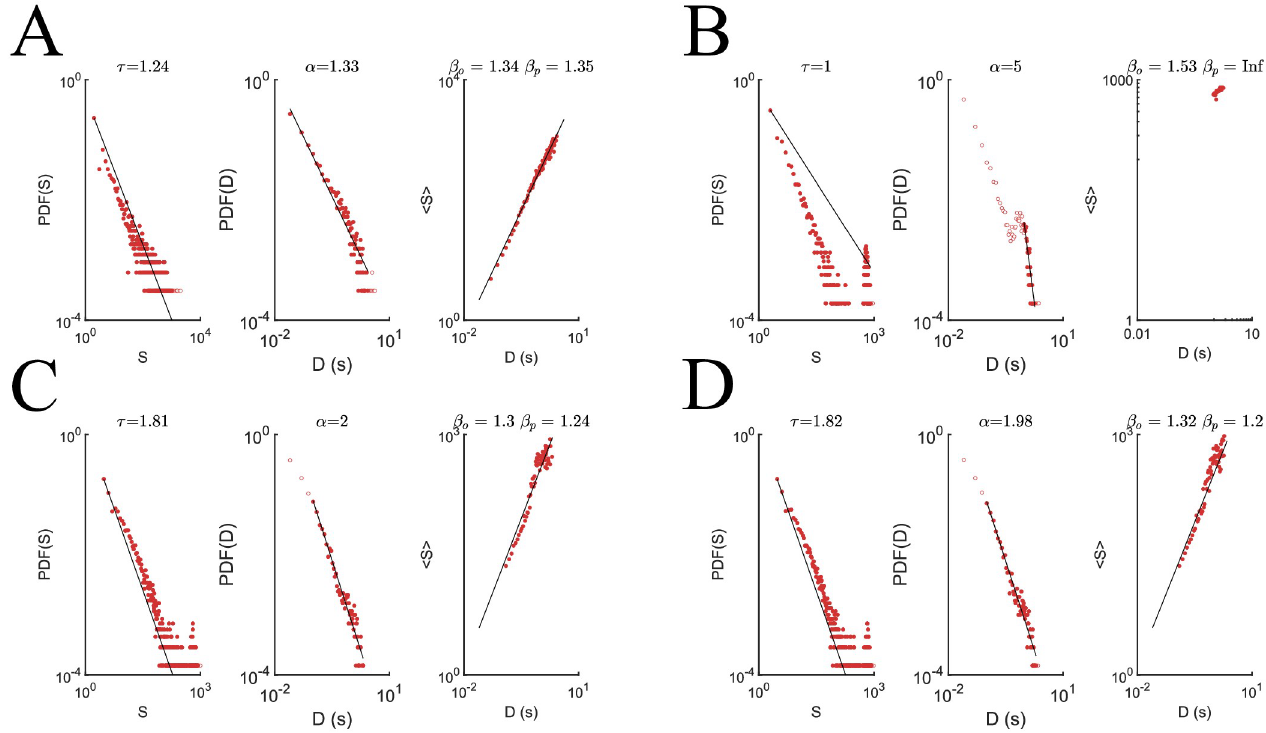
Fig 8. Improvement in ISI goodness of fit and basic spike statistics dependent on initial network configuration. ( A ) ℓ 2 distance measures between ISI histograms and basic spike statistics for uniform initial reference and naive networks (Methods). The plots are organized left to right for reference, naive, optimized, and finally control conditions. The ISI goodness of fit improves during optimization indicating similarity in the reference and optimized inter-spike interval distributions. For the uniform initial distributions, the control ISI ℓ 2 distances are lower on average than those of the optimized networks, but for all other initializations, the ISI ℓ 2 distance is lowest for the optimized condition. Means and variances of spike number are computed by recording the number of spikes in each neuron’s spike train and taking averages and variances over neurons. While the mean spike number is roughly unchanged through optimization (from naive to optimized), the variance in spike number diverges from the reference value. ( B ) For the gaussian initial network configuration, ISI ℓ 2 for the optimized network is greater on average than that of the control, but in both cases improves during learning. ( C ) For the sparse initial network configuration, PSPM improves network performance for both ISI goodness of fit and mean spike number but not for variance. ( D ) The naive-half-max initial configuration enjoys benefits in ISI goodness of fit and mean spike number but shows spike number variance again increasing with application of